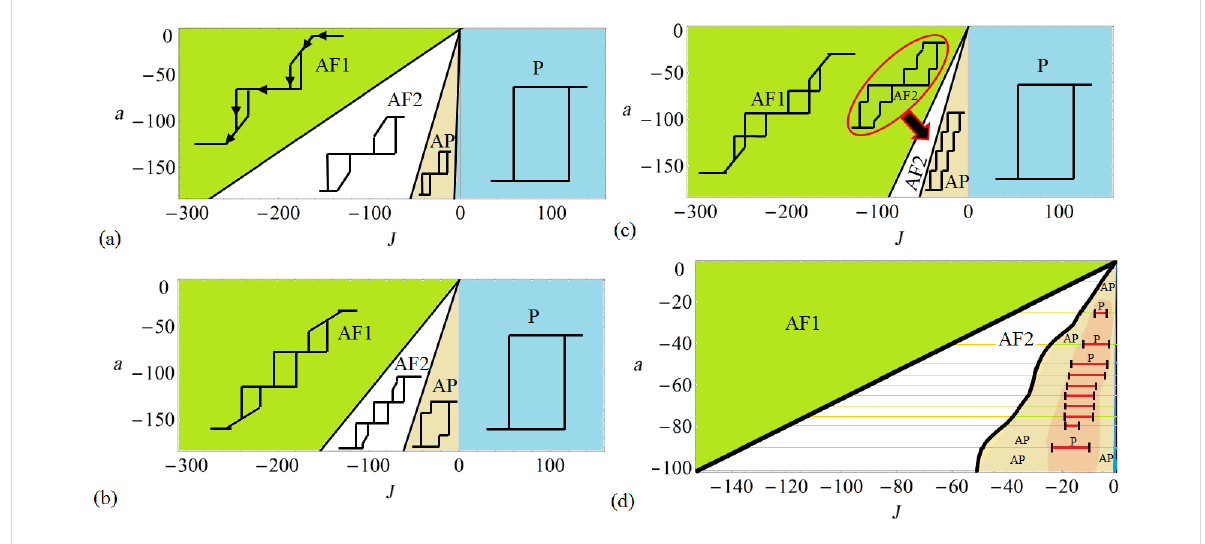
Figure 1: The magnetic phase diagrams of anisotropy, a , as a function of coupling strength J . In (a) N = 2, (b) N = 3, (c) N = 4 the phase diagrams are found through a quasi-static analysis. In (d) the dynamical results by using Equation 6 for N = 2 are shown. One can see that in the AP phase the hysteresis alternates between an AP and P phase, indicating that the AP phase is the least